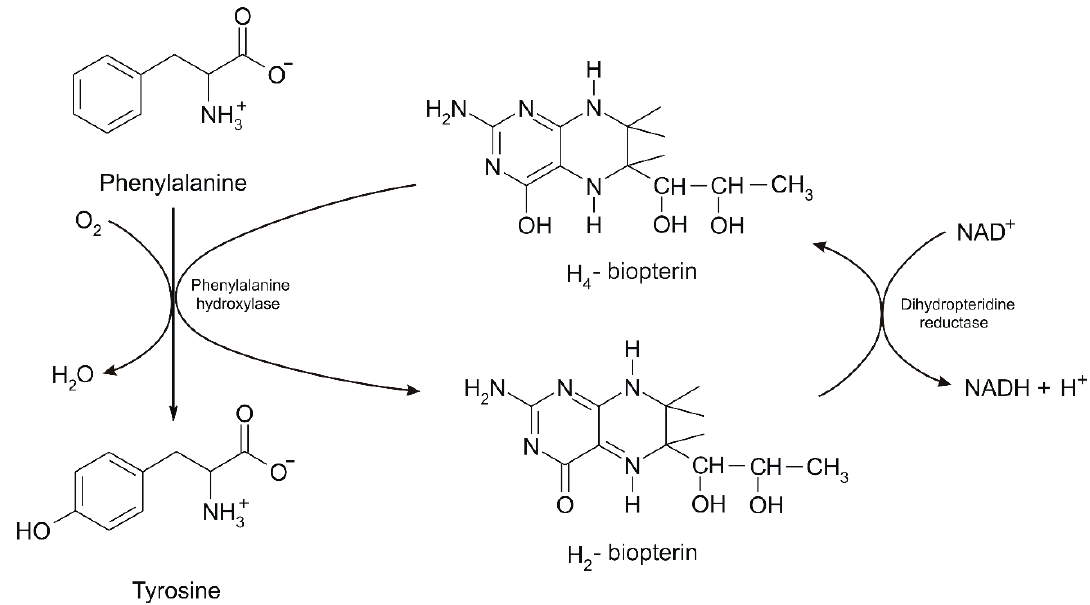
Figure 2. Transformation of L ‐ Phe into L ‐ Tyr biocatalyzed by PAH [1].